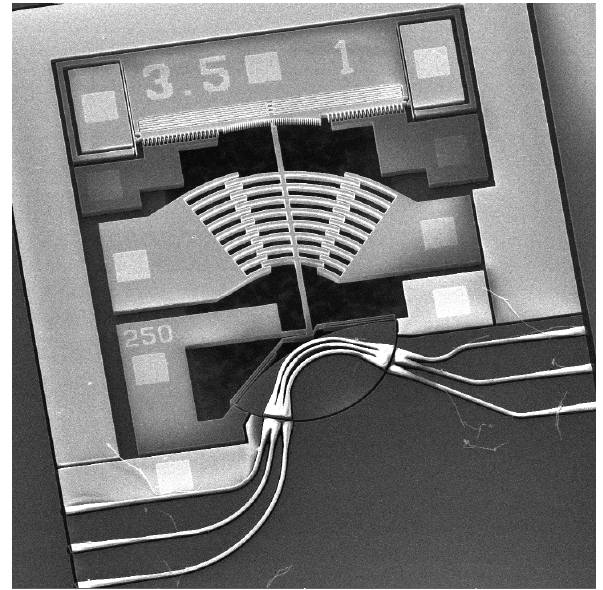
Figure 15. Simplified process flow ( a ) silicon-on-insulator (SOI) with patterned waveguides and Al pads, ( b ) front and back patterned Cr mask, ( c ) front protective layer and backside etch, ( d ) backside